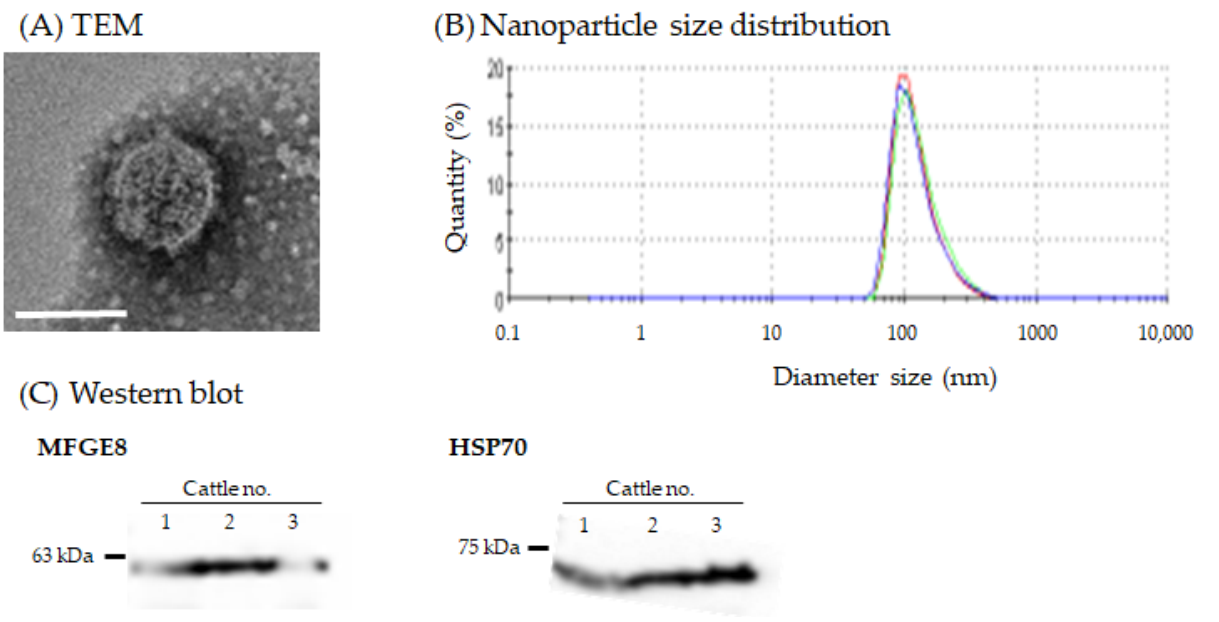
Figure 1. Characterization of milk sEVs. Representative data from cattle no. 1 are shown. ( A ) Transmission electron microscopy analysis shows the bilayer spherical shape of milk sEVs (scale bar, 100 nm). ( B ) Nanoparticle size analysis reveals that the peak of size distribution was observed to be around 100 nm in diameter. Size distribution was measured three times (red, green, and blue lines). ( C ) sEV surface and internal marker proteins MFGE8 and HSP70 were detected by Western blot analysis, indicating that milk sEVs were successfully isolated.